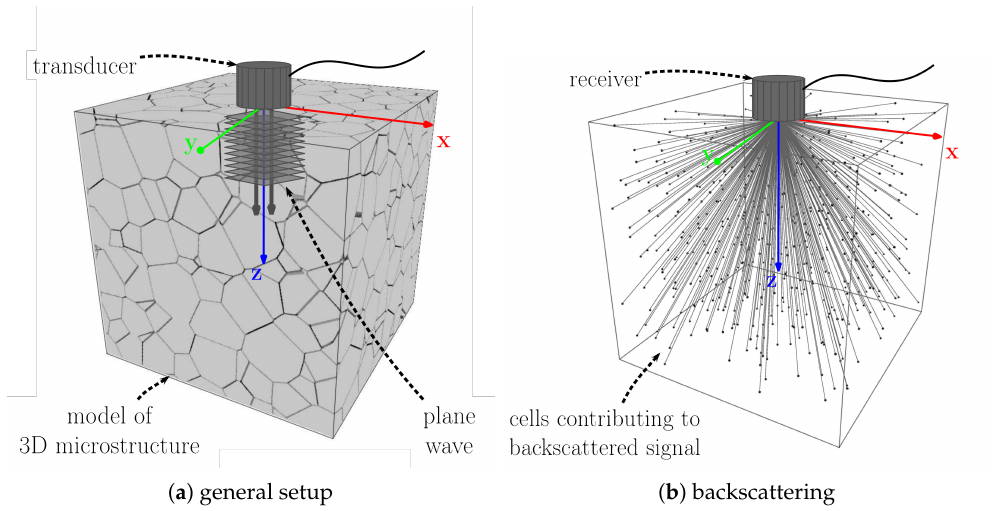
Figure 1. ( a ) Experimental setup assumed throughout including the particular choice of the global Cartesian coordinate system with top-down z-axis. The transducer is both transmitter and receiver for longitudinally polarized waves. In ( b ), dots mark the centers of the cells visualized in ( a ). The entire microstructure contributes to the received backscattered signal.